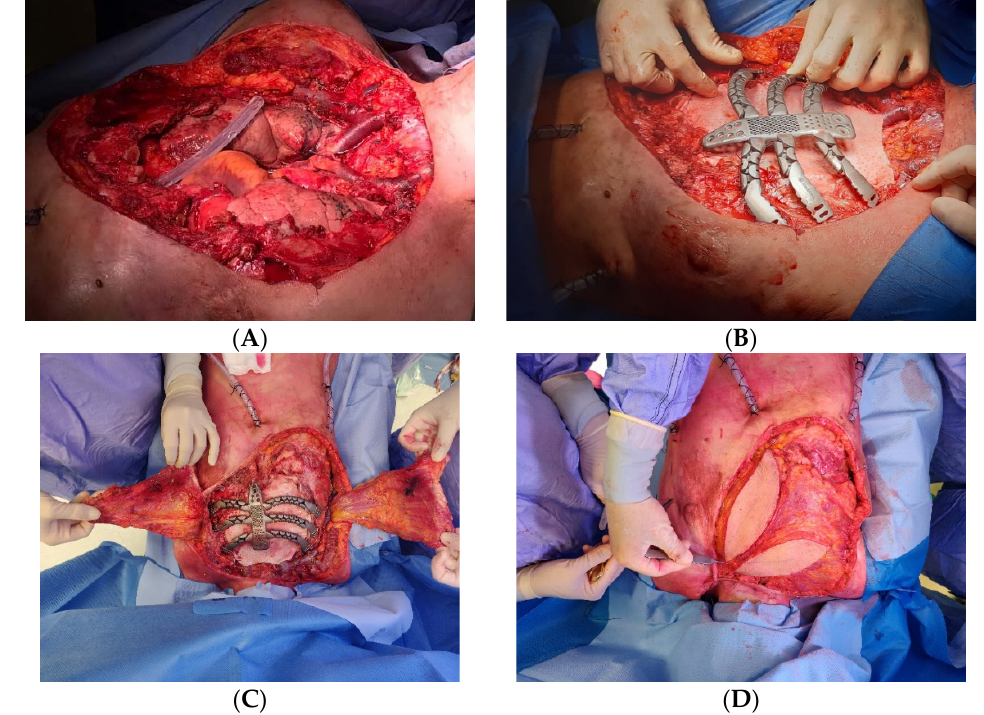
Figure 4. ( A ) Extended chest-wall resection for metastatic breast cancer. ( B ) Large defect coverage with biological prosthetic meshes and positioning of 3D custom-made titanium prothesis. ( C – D ) Latissimus dorsi myocutaneous flaps for sternal wound reconstruction.